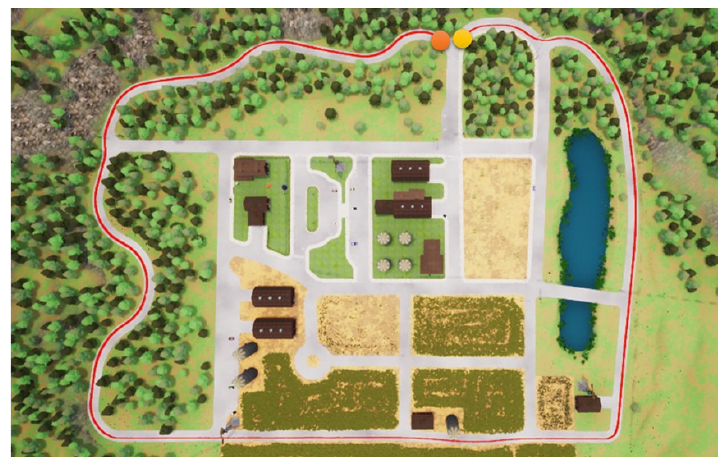
Figure 18. RDPG with an RGB camera for the second testing path.